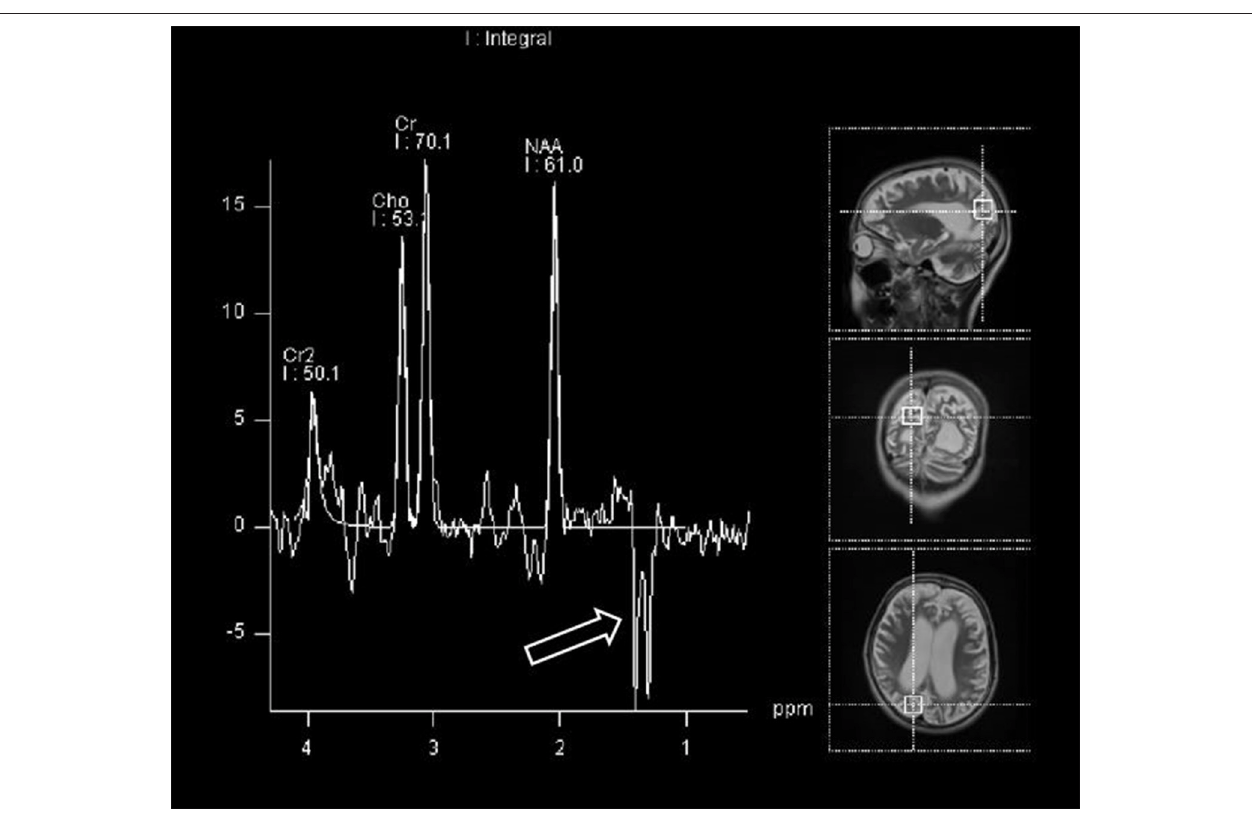
FIGURE 2 | Magnetic resonance spectroscopy (MRS) demonstrating lactate peak (open